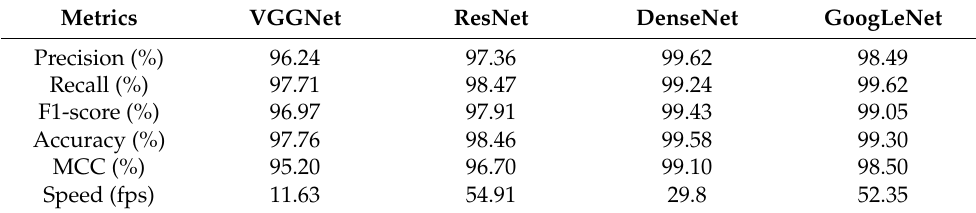
Figure 16. Casting product classification performance in testing phase. Table 7. Casting product classification performance.